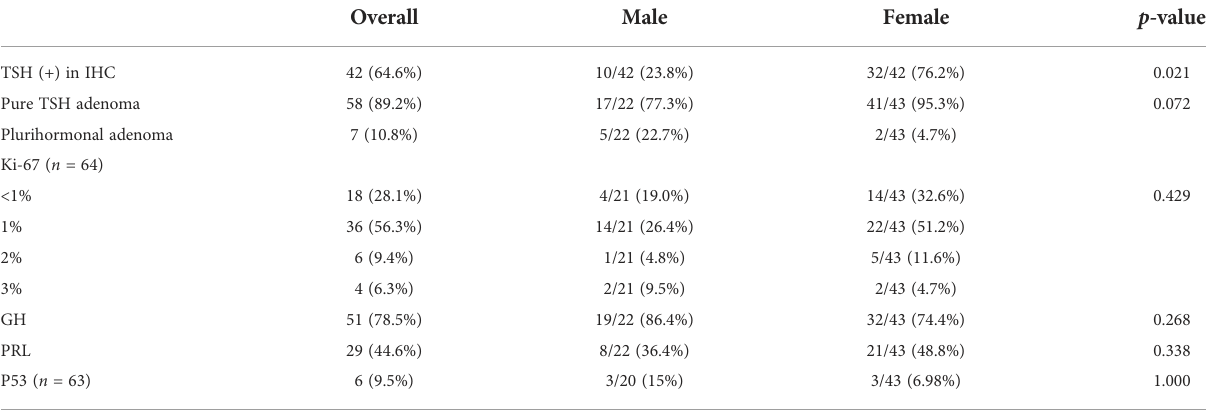
TABLE 6 Histological fi ndings.